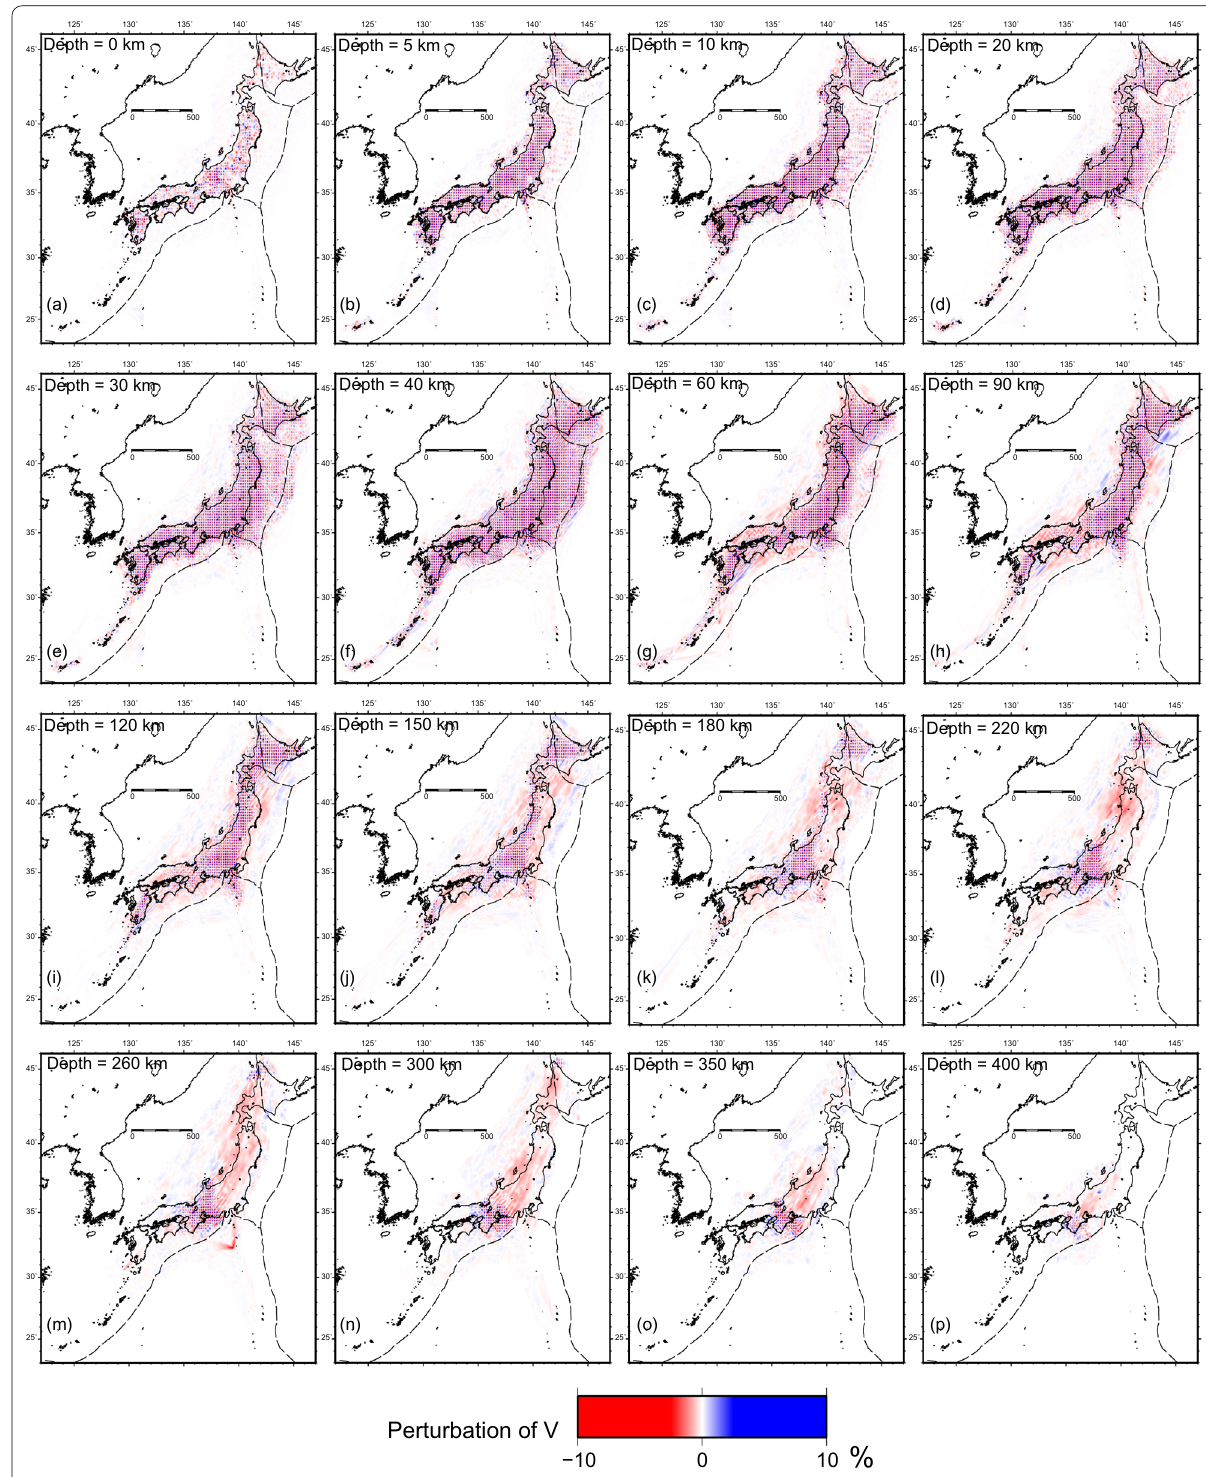
Fig. 7 Result of checkerboard resolution test for